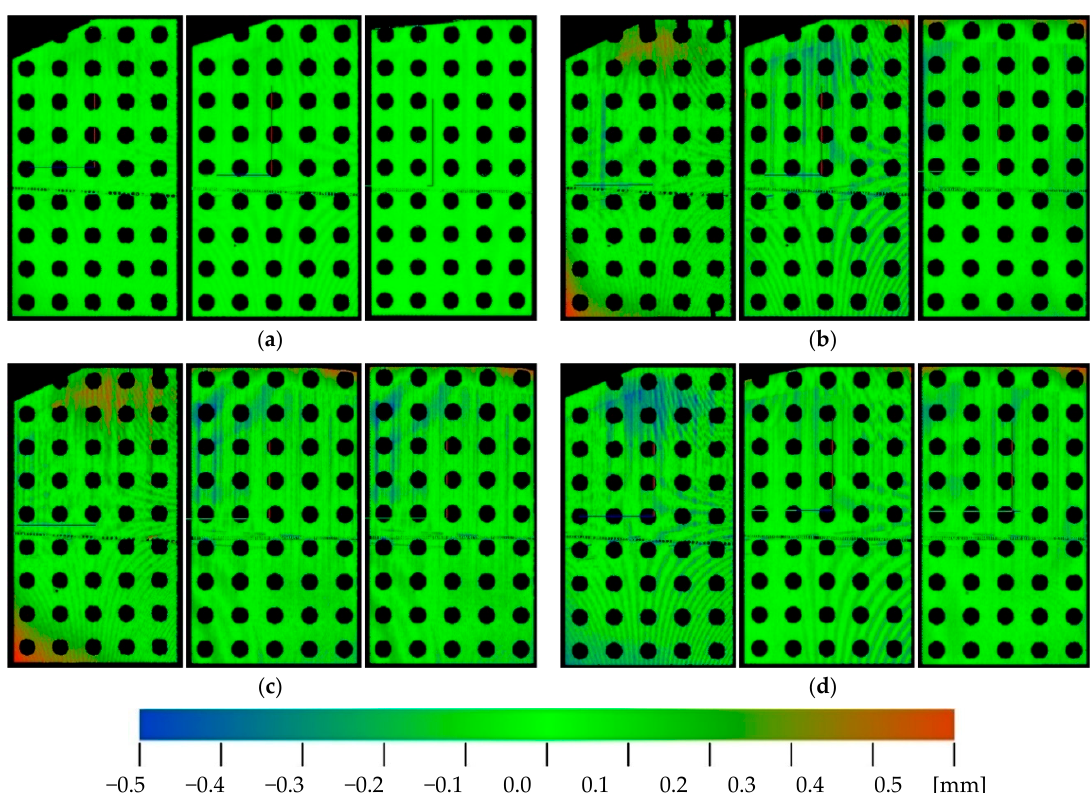
Figure 12. Calibration artefact positions employed in the validation analysis.